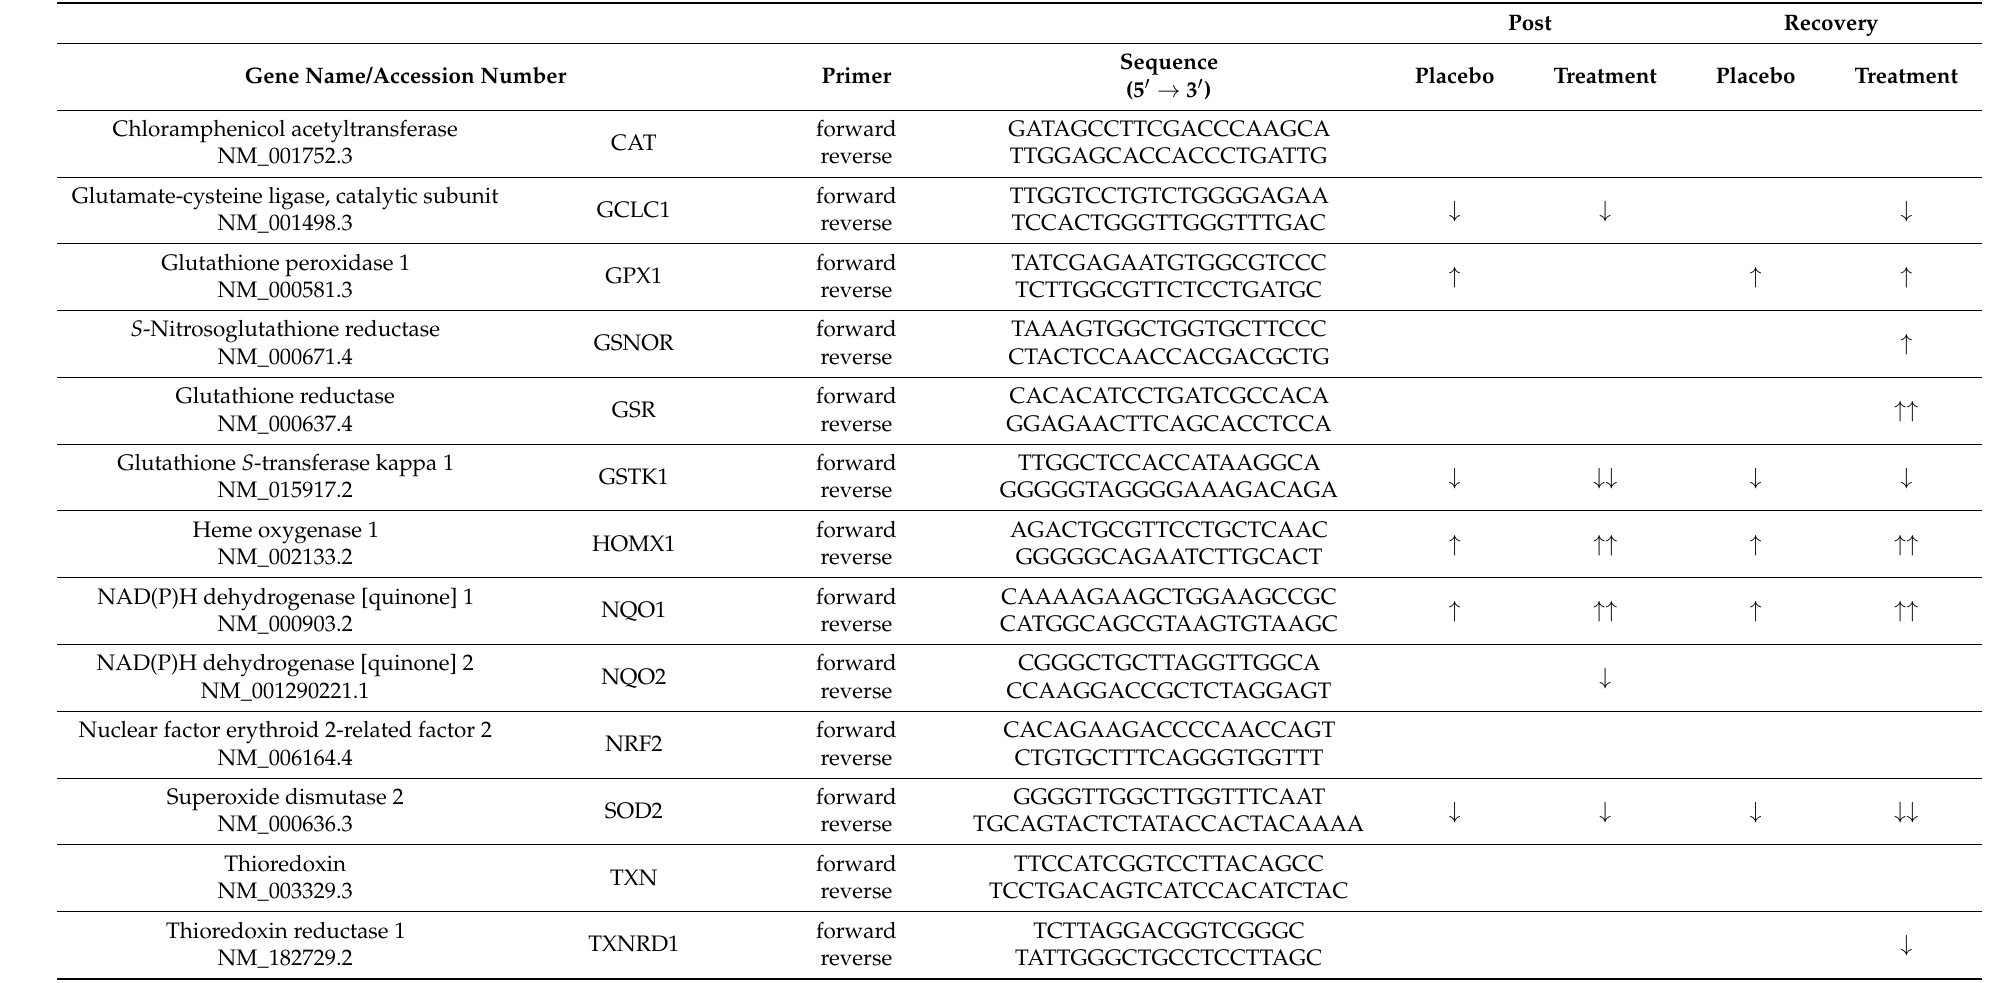
Arrow: indicates direction of the trend of change. Two arrows: more pronounced compared to one arrow